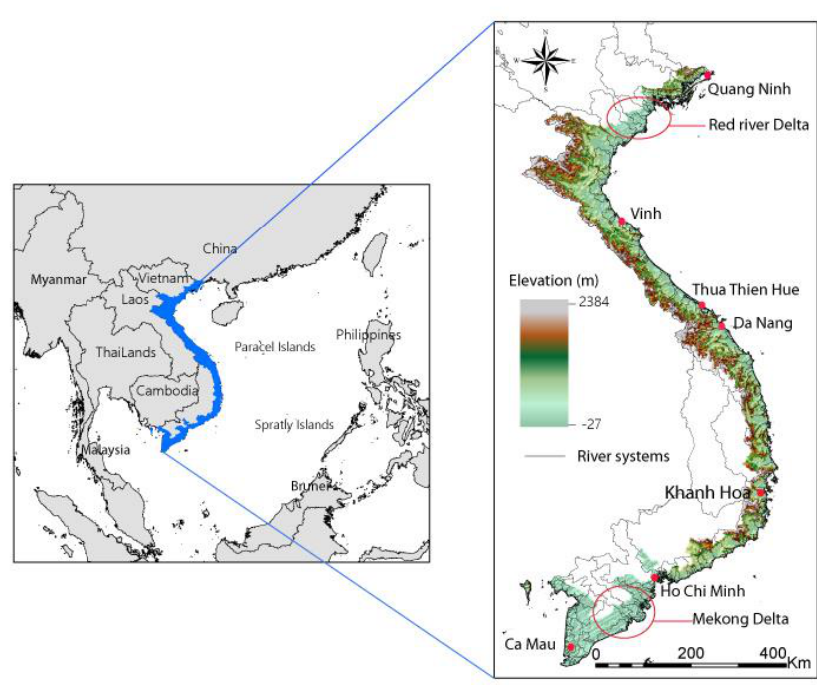
Figure 3. Location of the Vietnam shoreline (blue) in Vietnam and Asia (gray). White areas correspond to the seas. Source: made by H.D.N. using official data.